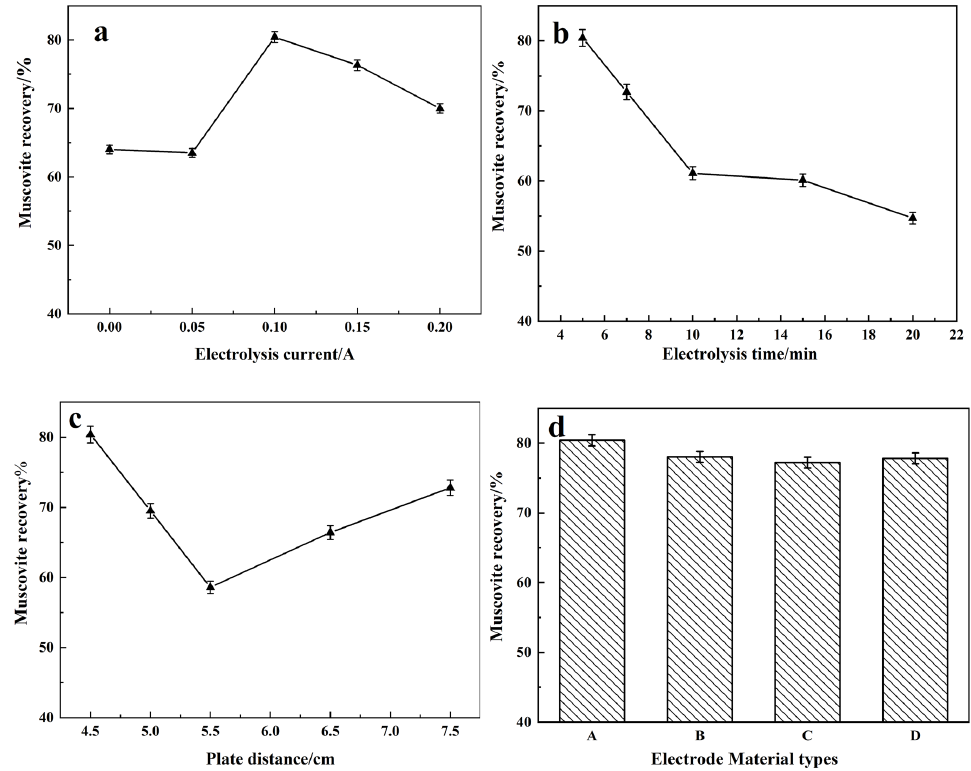
Figure 5. Effects of Cu 2+ on floatability of muscovite under different electrochemical treatment conditions (pH = 12, c (Sodium oleate) = 9.20 × 10 − 4 mol / L, c (Cu 2 + ) = 6 × 10 − 5 mol / L). ( a ), electrolysis conditions (pH = 12, c (Sodium oleate) = 9.20 × 10 −4 mol/L, c (Cu 2+ ) = 6 × 10 −5 mol/L). ( a ), electrolysis current; ( b ), electrolysistime; ( c ), platedistance; ( d ), electrodematerialtypes—A:graphiteplate–graphite current; ( b ), electrolysis time; ( c ), plate distance; ( d ), electrode material types—A : graphite plate; B: copper plate–graphite plate; C: lead board–graphite plate; D: stainless steel plate – graphite plate ; B : copper plate – graphite plate; C: lead board – graphite plate; D: stainless steel plate – graphite.